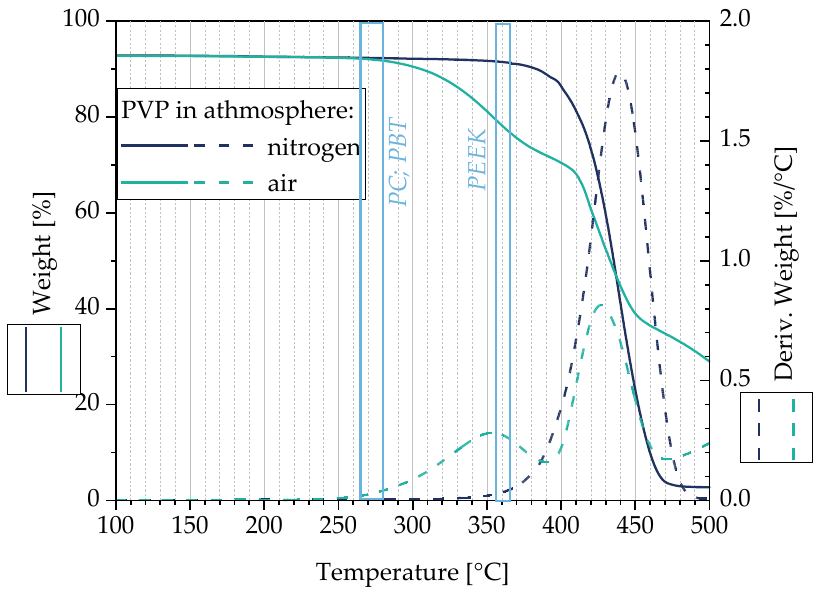
Figure 2. Thermal degradation behavior of PVP.